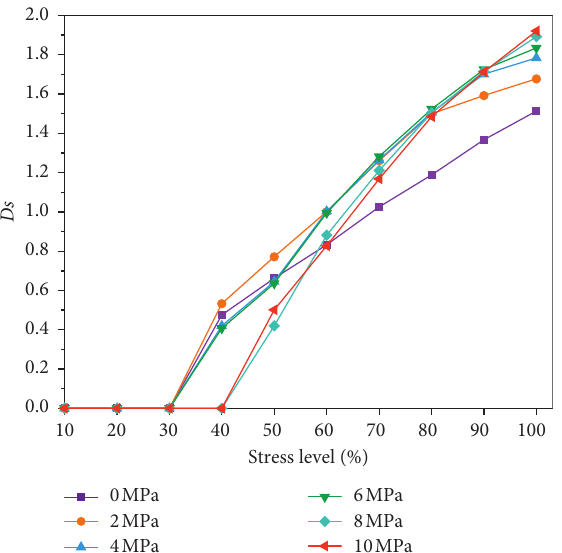
Figure 17: Relationship between stress levels and fractal dimensions under different confining